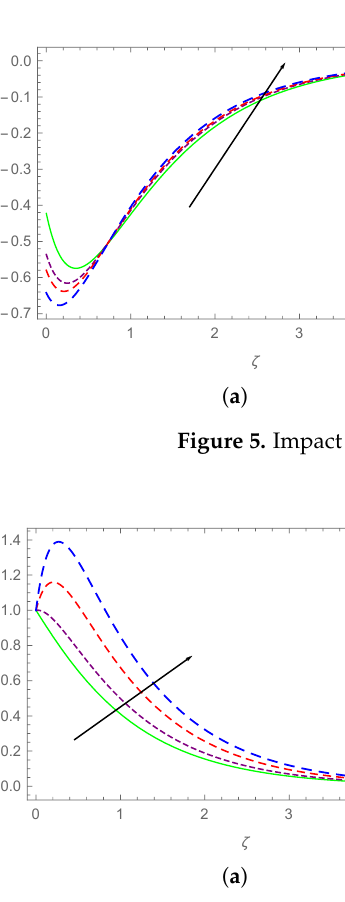
Figure 6. Impact of We on the horizontal velocity components ( a ) F (cid:48) ( ζ ) and ( b ) G (cid:48) ( ζ ) . The influence of Λ upon F ( ζ ) and G ( ζ ) (the vertical velocity profiles) is portrayed in Figure 7. We observe that both the vertical components show almost similar increasing dependence with the augmenting values of Λ .